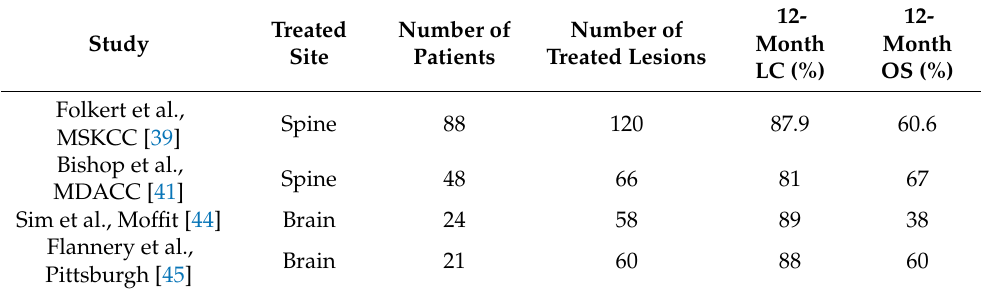
Table 2. SBRT for spine and brain metastasis in soft tissue